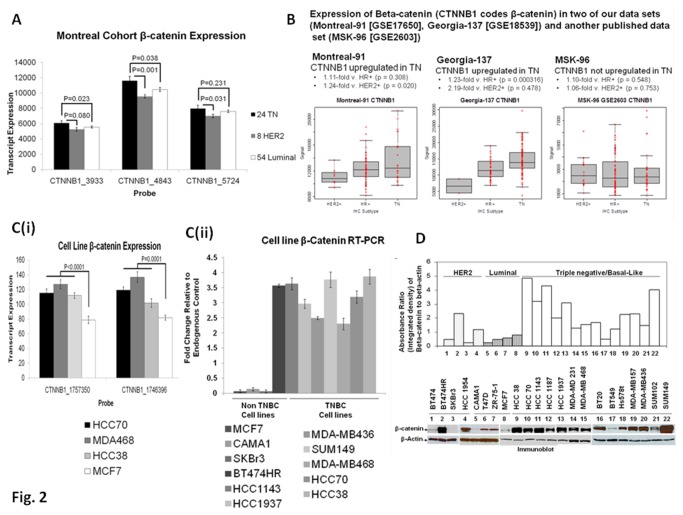
Expression of beta-catenin mRNA and protein in patients with TN breast tumors and cell lines.Expression of beta-catenin mRNA in patients with TN breast tumors (A), the expression of beta-catenin in two of our data sets (Montreal-91 [GSE17650], Georgia-137 [GSE18539]) and another published data set (MSK-96 [GSE2603]) (B), the expression of beta-catenin mRNA in different breast cancer cell line (C), and the expression of beta-catenin protein in different breast cancer cell line (D) are shown. (A) Expression of CTNNB1 probes that code the beta-catenin protein in the Montreal cohort. Mean expressions of three CTNNB1 probes (Montreal cohort) for TN (black), HER2+ (grey), and luminal (white) patients indicate greater levels of expression in the TN subtype as compared to luminal and HER2+ subtypes. Error bars represent one standard error of the mean and p-values are determined using t-test for unequal sample sizes and means. (B) Expression of beta-catenin (CTNNB1 encodes beta-catenin) with respect to immunohistochemistry (IHC) subtype in two of our data sets (Montreal-91 [GSE17650], Georgia-137 [GSE18539]) and another published data set (MSK-96 [GSE2603]). beta-catenin is up-regulated in TN as compared to the HER2+ group in the Montreal cohort (p = 0.020) and as compared to luminal (HR+) group in the Georgia-137 cohort (p = 0.000316) (C i). Expression of CTNNB1 in four BT cell lines. Expression of CTNNB1 in four cell lines, including three TN breast cancer cell lines HCC70 (black), MDA-MB-468 (dark grey), HCC38 (light grey), and one luminal-like cell line MCF7 (white). Values represent the mean of three replicates, and error bars represent one standard error of the mean. P-values are determined using a t-test for unequal sample sizes and means (C ii). RT-PCR expression of mRNA for beta-catenin in different BT cell lines (TNBC and Non-TNBC). Values represent the mean of three replicates, and error bars represent one standard error of the mean. (D) Differential expression of beta-catenin protein in different TN breast cancer cells (lanes 9-22) as compared to HER2+ (lanes 1-4), and luminal-like (lanes 5-8) breast cancer (BC) cell lines (beta-actin as the loading control). Upper panel shows the quantification of beta-catenin protein using imageJ program (absorbance ratio of beta-catenin to beta-actin).